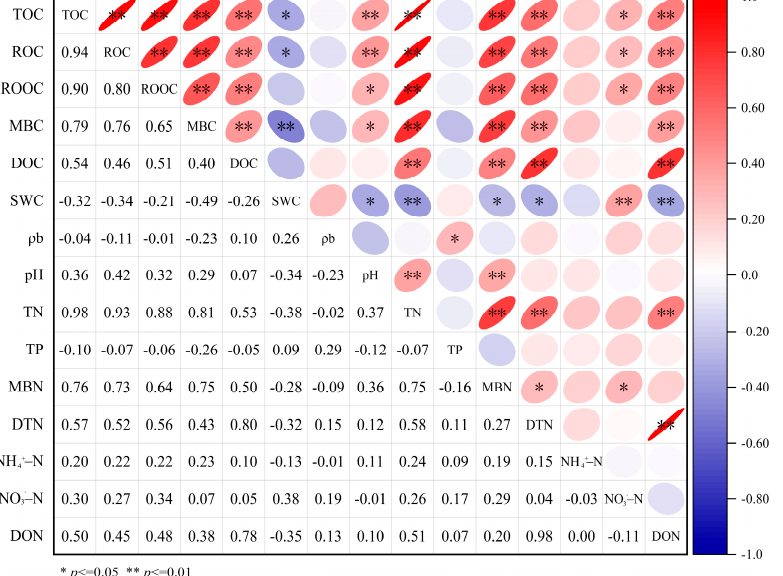
Figure 4. Correlation coefficients between soil carbon components with soil physicochemical factors. SWC (Soil moisture content); ρ b (Bulk density); pH (pH); TN (Total nitrogen); TP (Total phosphorus); NH 4+ -N (Ammonium); NO 3 − -N (Nitrate); DTN (Dissolved total nitrogen); DON (Dissolved organic nitrogen); MBN (Microbial biomass nitrogen); TOC (Total organic carbon); ROC (Recalcitrant organic carbon), ROOC (Readily oxidizable organic carbon); MBC (Microbial biomass carbon); DOC (Dissolved organic carbon). The numbers in the graph represent the correlation coefficient r; red indicates positive correlation; blue indicates negative correlation; * indicates significant correlation at 0.05 level; ** indicates significant correlation at 0.01 level. Redundancy analysis (RDA) was carried out with the mass fraction of SOC components in different soil layers as response variables and soil physicochemical factors as environmental explanatory variables, and the results are shown in Figure 5. The cumulative explanatory amounts of the first and second principal axes in the four soil layers to soil physicochemical properties and organic carbon components were 92.67%,